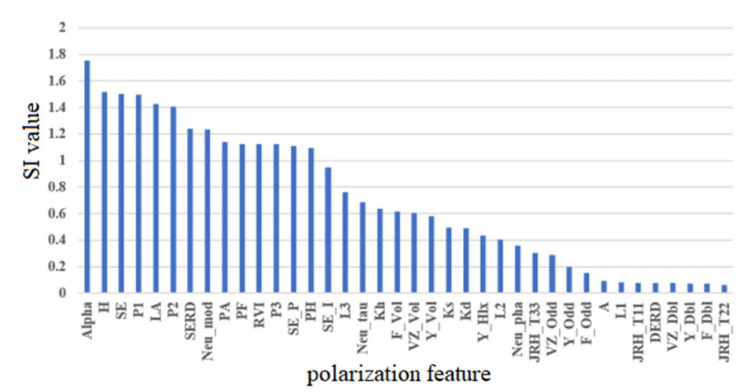
Figure 4. The separability index of different features to lakes.